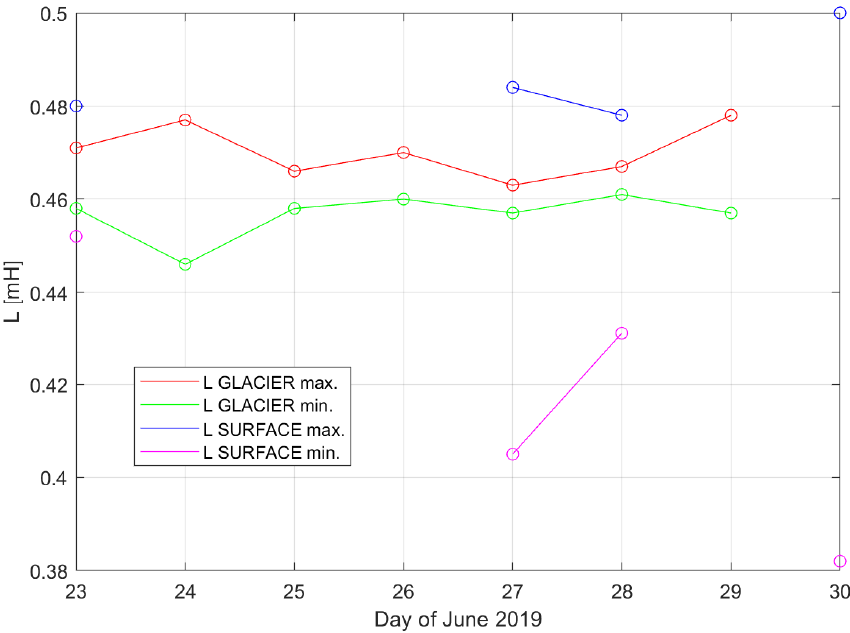
Figure 3. Measured inductances of the glacier- and surface loop antennas.